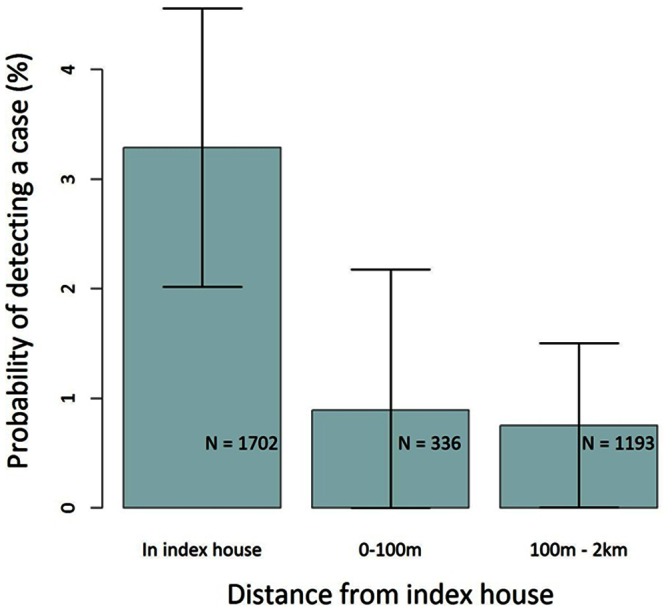
Probability of detecting a secondary case within different search distances from index households.
Error bars indicate the 95% confidence intervals (adjusted for intra-household correlation).